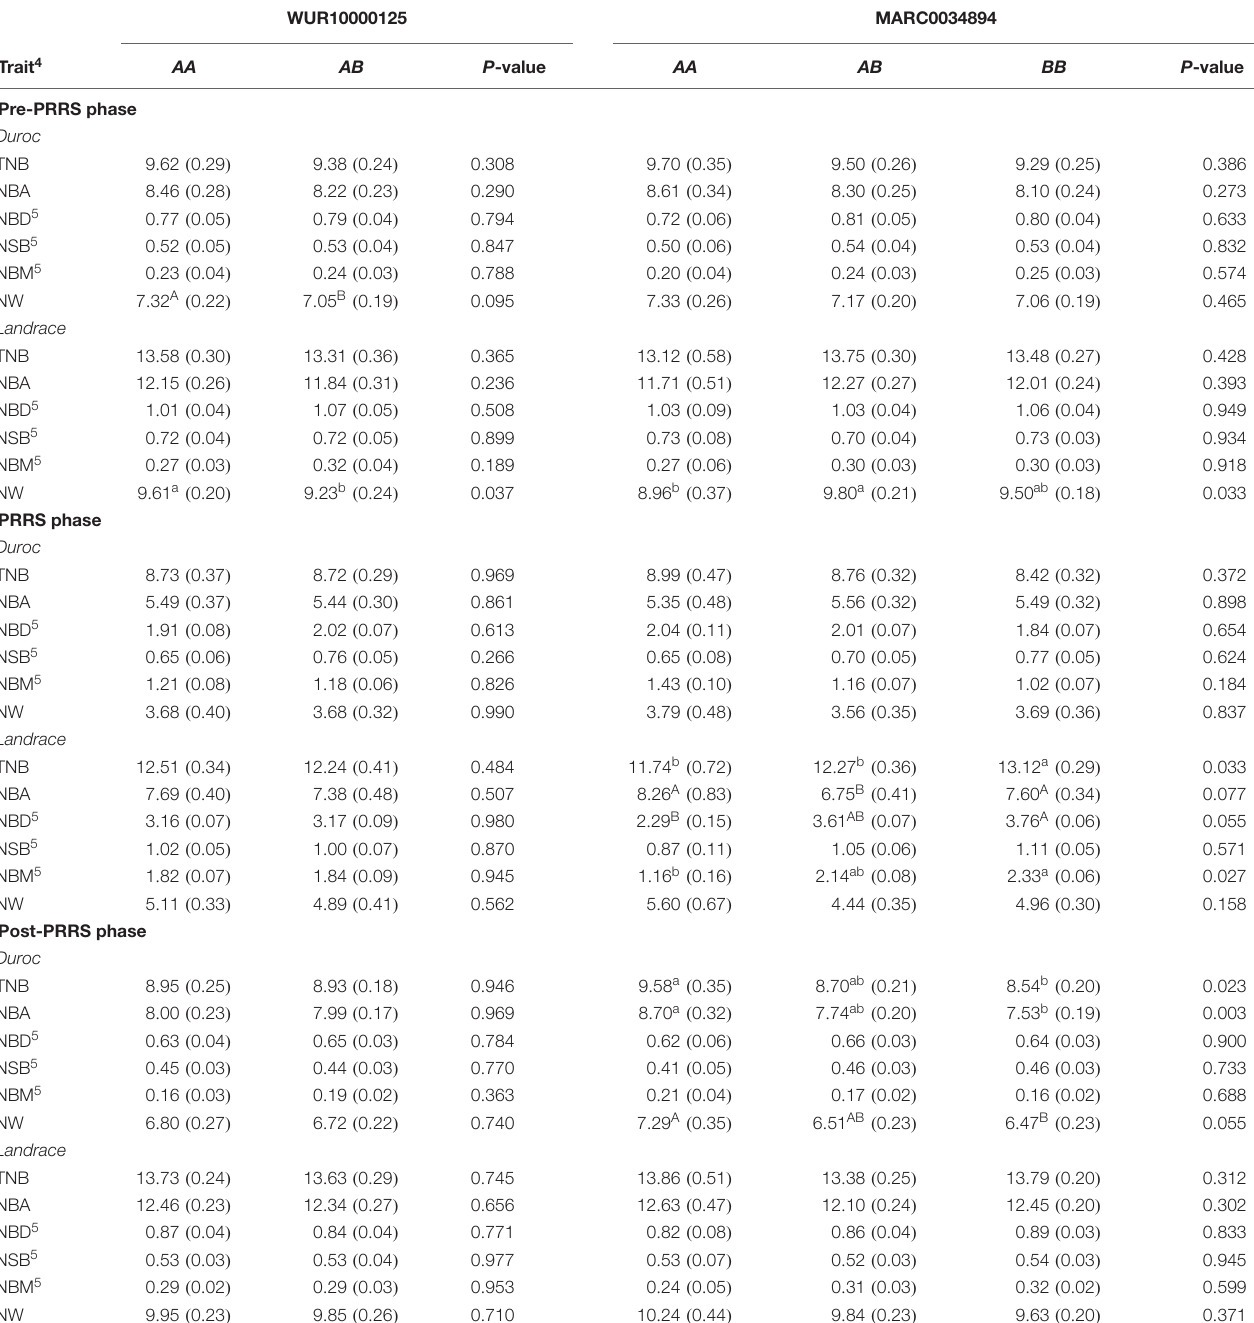
TABLE 7 | Least squares means 1 (SE) for reproductive traits across PRRS 2 phases for genotypes at the WUR10000125 and MARC0034894 SNP 3 in Duroc and Landrace